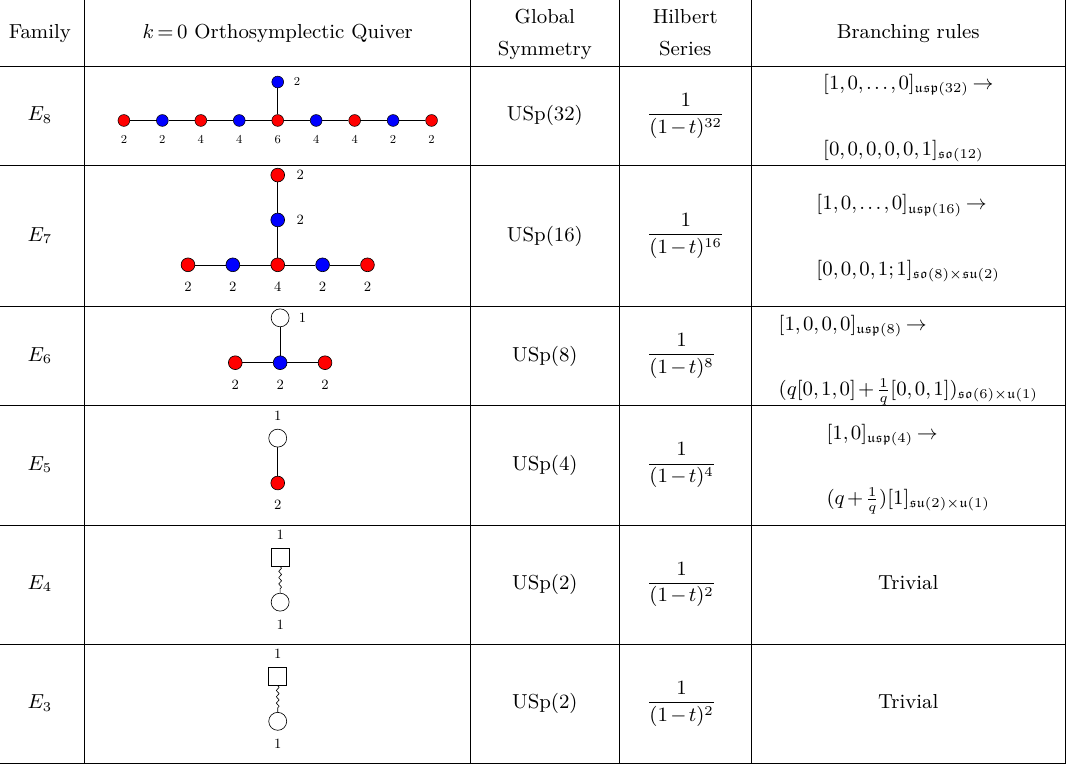
Table 17. The k = 0 limit of the family of E n quivers in table 15. The choice of discrete group is H = Z 2 . For n < 3 , the k = 0 limit is trivial. The last column lists the branching rules for the fundamental representation of the USp global symmetry group of the free theory to the global symmetry group in the k = 0 limit of table 15. Note the nice pattern of power of